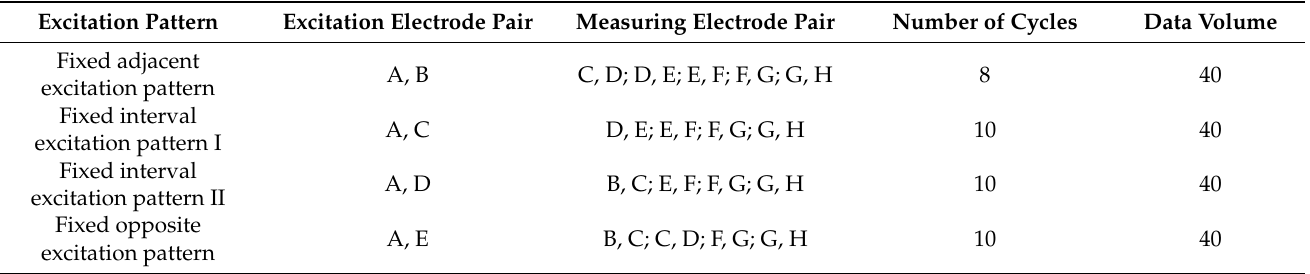
Table 1. Data collection details for different measurement methods.